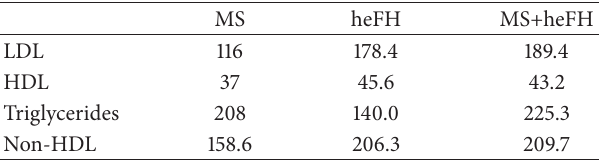
Table 3: Lipid values by group in